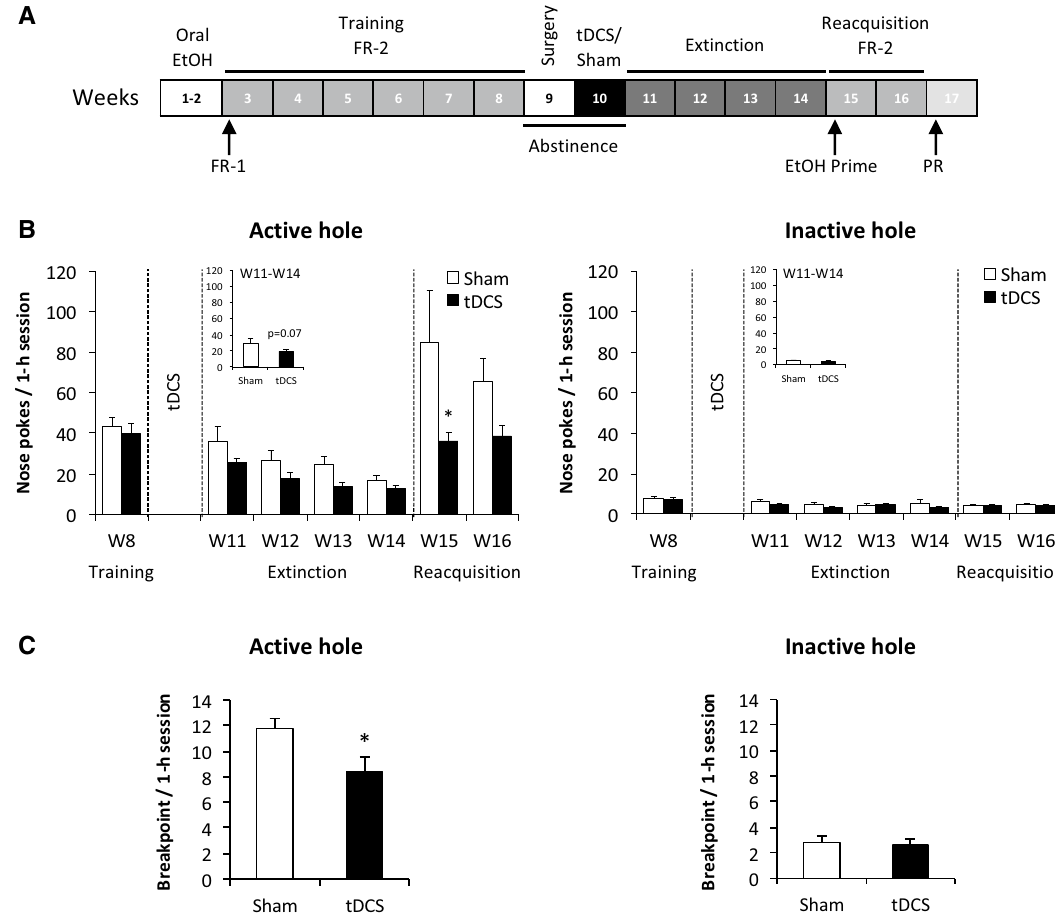
Figure 4. tDCS reduces the reacquisition of ethanol consumption after extinction and the motivation to obtain ethanol in an operant ethanol self-administration paradigm. ( A ) Experimental design. ( B ) Number of nose pokes per session in the active (left) and inactive (right) holes during training before tDCS (week 8, W8) and during extinction (W11-W14) and reacquisition (W15-W16) after tDCS. The average number of nose pokes during extinction (W11-W14) is depicted in the insets (active hole, left; inactive; right). * P ≤ 0.05, tDCS vs. sham. ( C ) Motivation to obtain a dose of ethanol, evaluated using a progressive ratio schedule. The breakpoint is lowered in tDCS animals (active hole, left; inactive hole, right). * P ≤ 0.05, tDCS vs.